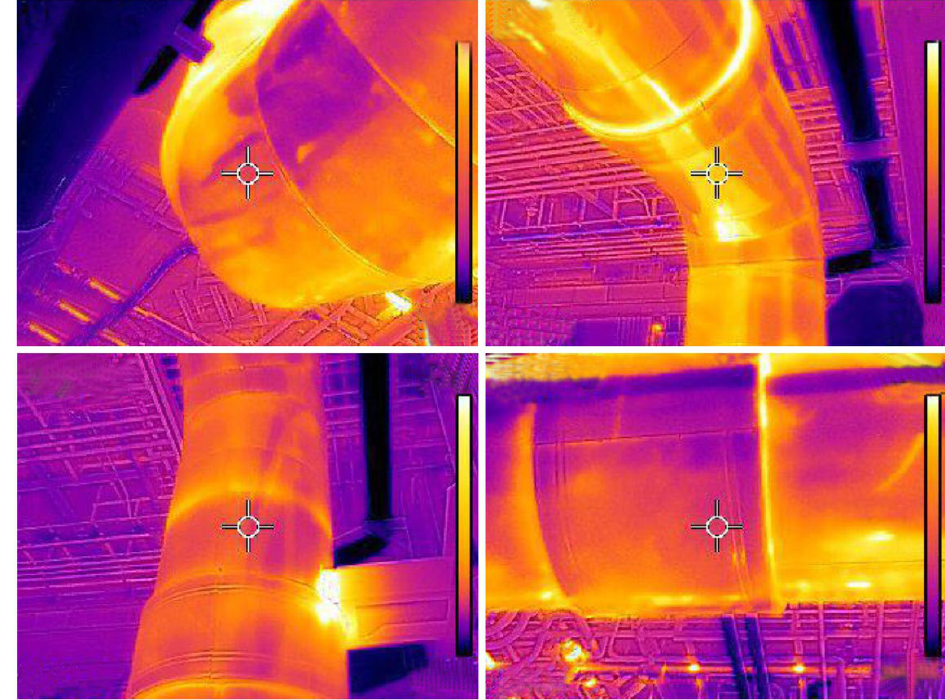
Figure 3. Thermal inspection of areas for the TEG applications.